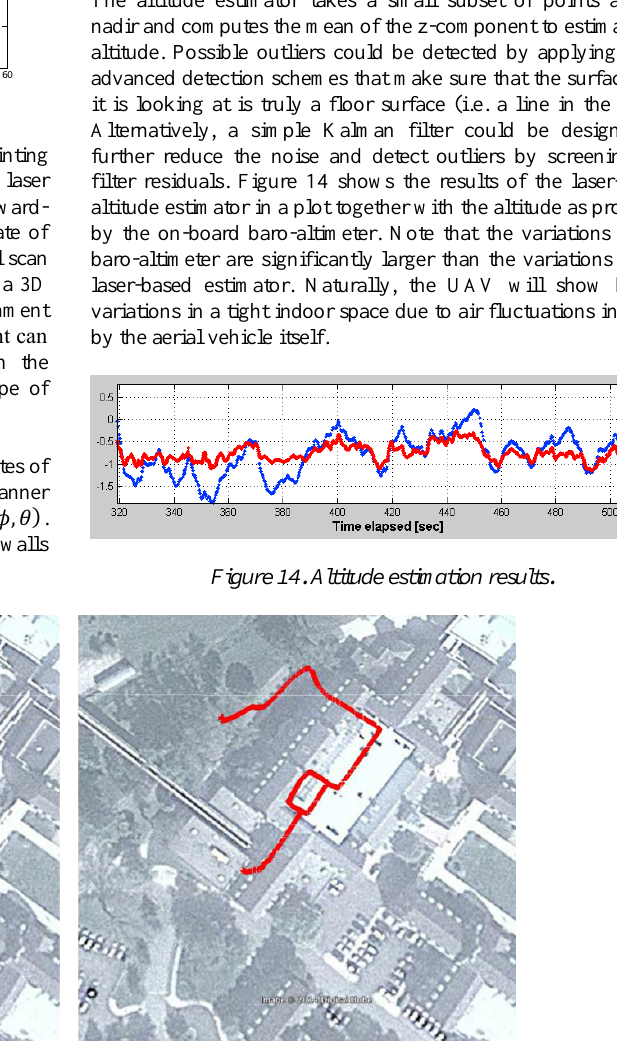
Figure 15. Results (left) no integration of GPS with SLAM solution; (right) integration of GPS with SLAM